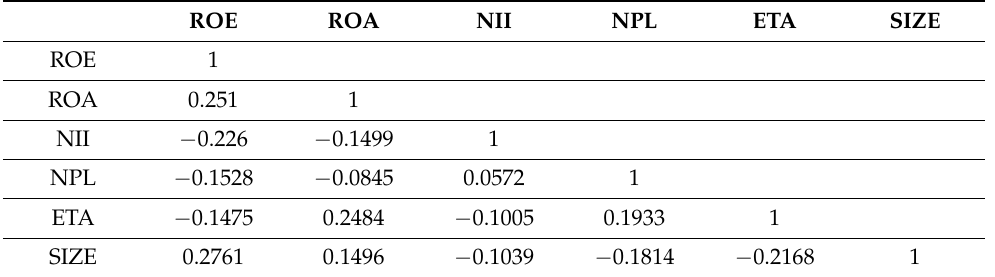
Table 3. Correlation matrix.